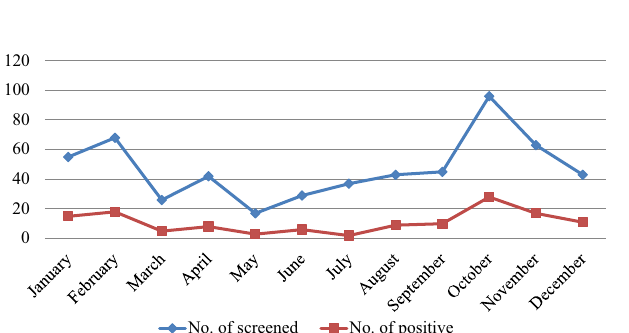
Figure 2. Trends of VL positivity rate at Tefera Hailu Memorial Hospital, Sekota, Northeast Ethiopia from January 2017 to December 2021.